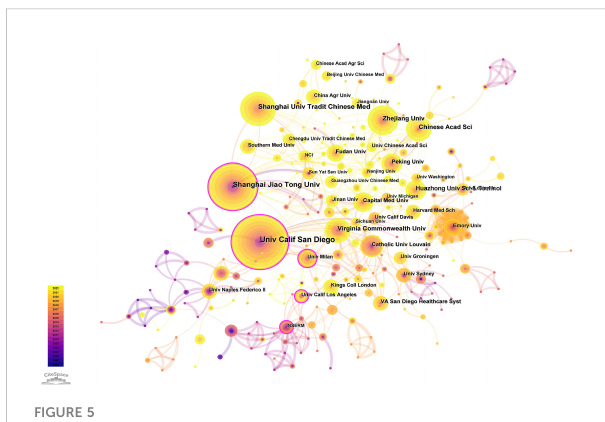
FIGURE 5 The network of institutions conducting research related to the gut- liver axis in NAFLD.